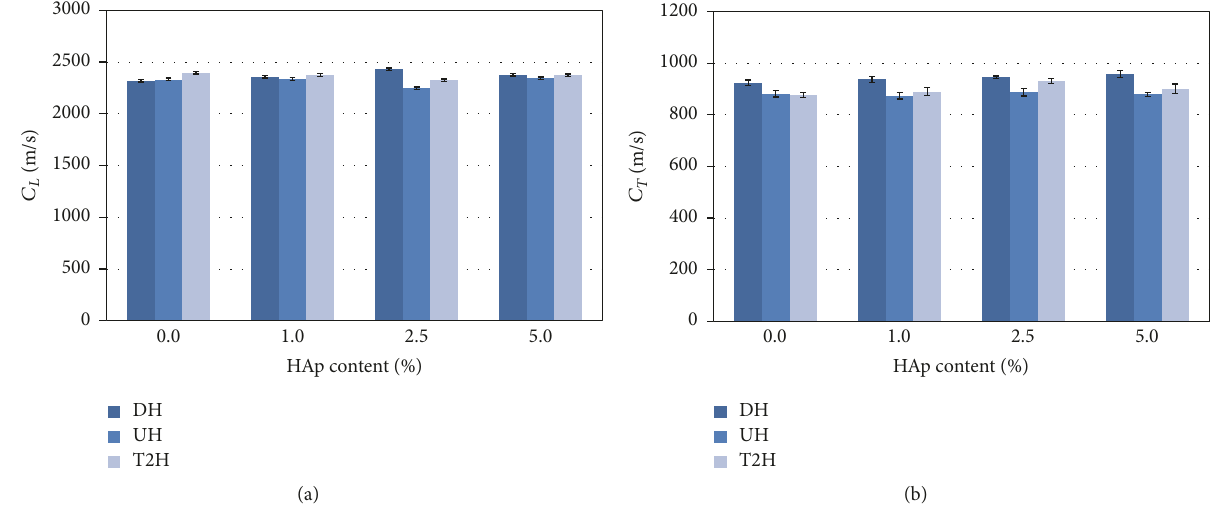
Figure 8: Longitudinal wave velocity ( 𝐶 𝐿 ) (a) and transverse wave velocity ( 𝐶 𝑇 ) (b) of POM and POM/HAp nanocomposites with different HAp content.